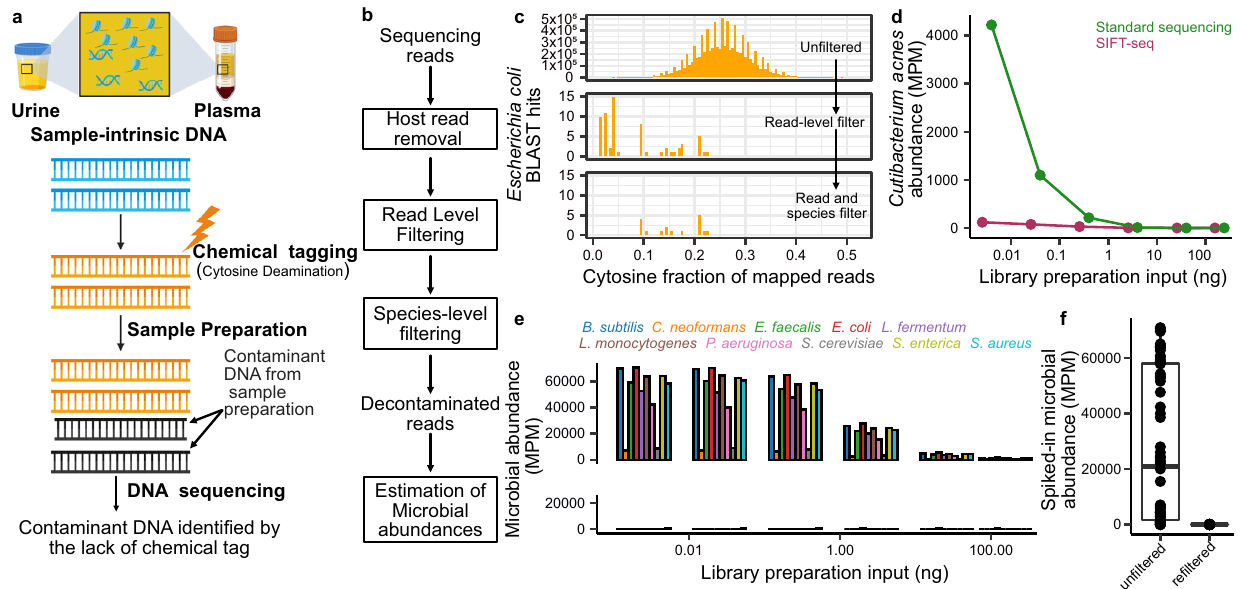
Fig. 1 SIFT-seq proof-of-principle. a Experimental work fl ow. Tagging of sample-intrinsic DNA by bisul fi te DNA treatment is performed directly on urine or plasma. Contaminating DNA introduced after the tagging step is identi fi ed based on lack of cytosine conversion. b Bioinformatics work fl ow. c Representative example of the cytosine fraction of mapped reads in an un fi ltered (top) dataset, a read-level fi ltered dataset (middle) and a fully fi ltered dataset (bottom). d Number of reads assigned to Cutibacterium acnes (common environmental DNA contaminant) in Φ X174 DNA after conventional sequencing (green) and SIFT-seq (purple). e Deliberate contamination assay. Detection of known contaminants before (top) and after (bottom) fi ltering. f Number of reads assigned to contaminants. Boxes in the boxplots indicates 25th and 75th percentile, the band in the box indicated the median and whiskers extend to 1.5 × Interquartile Range (IQR) of the hinge. Outliers (beyond 1.5 × IQR) are plotted individually. Source data for ( d – f ) are provided as a Source Data fi